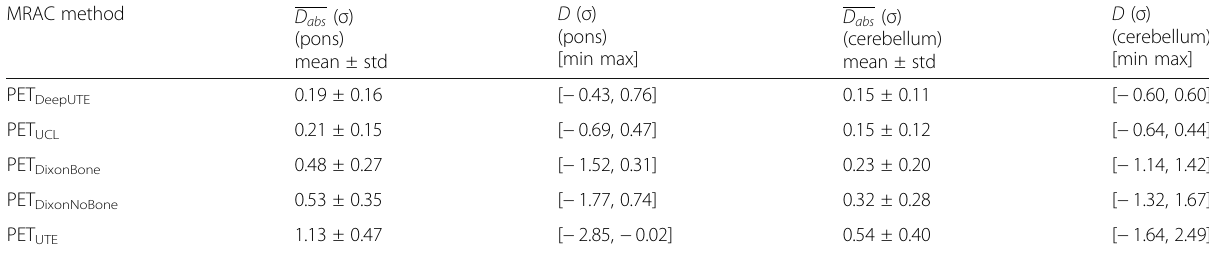
Table 3 The mean absolute difference ( D abs ) in z-score between PET MRAC and PET CT and the range of the difference ( D ), with pons and cerebellum as reference regions